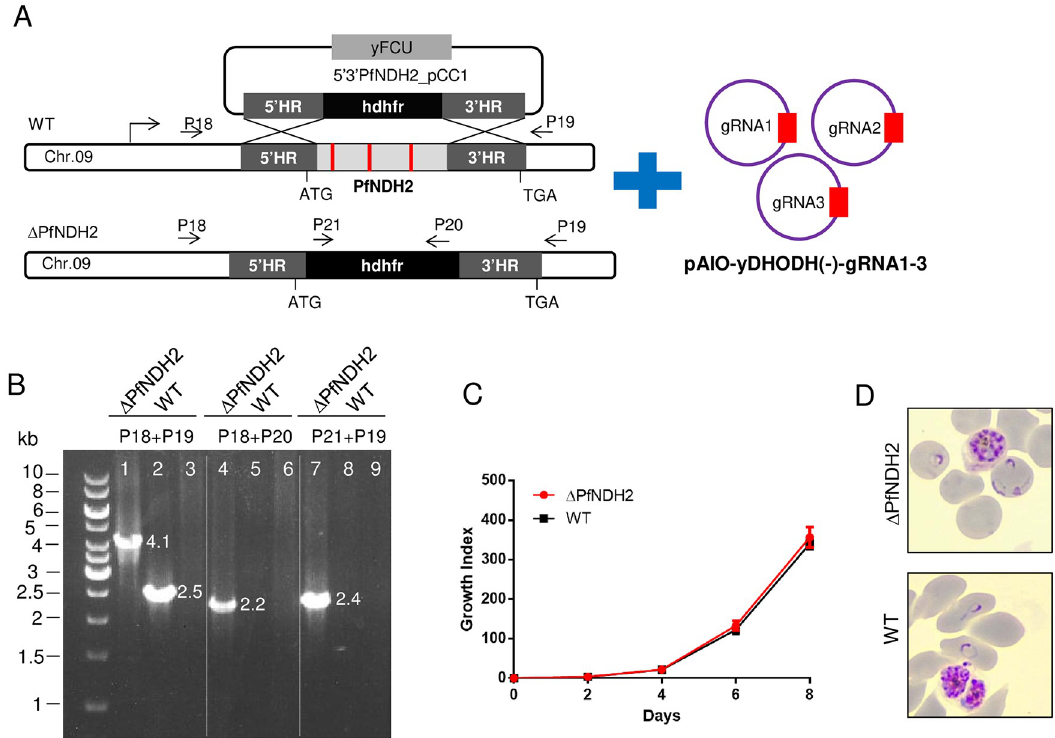
Fig 1. Disruption of the type II NADH dehydrogenase of P . falciparum does not affect growth in asexual blood stages. (A) A schematic diagram depicts the genetic deletion of a large segment of PfNDH2 via CRISPR/Cas9-assisted homologous recombination. The knockout plasmid (5’3’PfNDH2_pCC1) was co-transfected with three gRNA constructs made in pAIO-Cas9-yDHOD(-) (see Materials and methods). 5’HR, 5’ homologous region; 3’HR, 3’ homologous region. yFCU, yeast fusion gene of cytosine deaminase and uracil phosphoribosyl transferase. hdhfr, human dihydrofolate dehydrogenase. ATG is the start codon of PfNDH2 gene and TGA is the stop codon. (B) A diagnostic PCR confirming the genotype of the Δ PfNDH2 parasite. Primer positions are shown in (A). In Δ PfNDH2, a 4.1 kb knockout band (Lane 1), a 2.2 kb 5’ integration band (Lane 4) and a 2.4 kb 3’ integration band (Lane 7) were detected. In WT, only a 2.5 kb band was detected (Lane 2) whereas no 5’ integration (Lane 5) or 3’ integration (Lane 8) was observed. Lanes 3, 6, and 9 were negative controls with no DNA in PCR reactions. (C) A growth curve of the Δ PfNDH2 parasite determined by SYBR green staining and flow cytometry analysis (Materials and methods). (D) The Δ PfNDH2 parasite is morphologically healthy. Representative Giemsa stained thin smears of WT and Δ PfNDH2 cultures are shown displaying schizont and ring